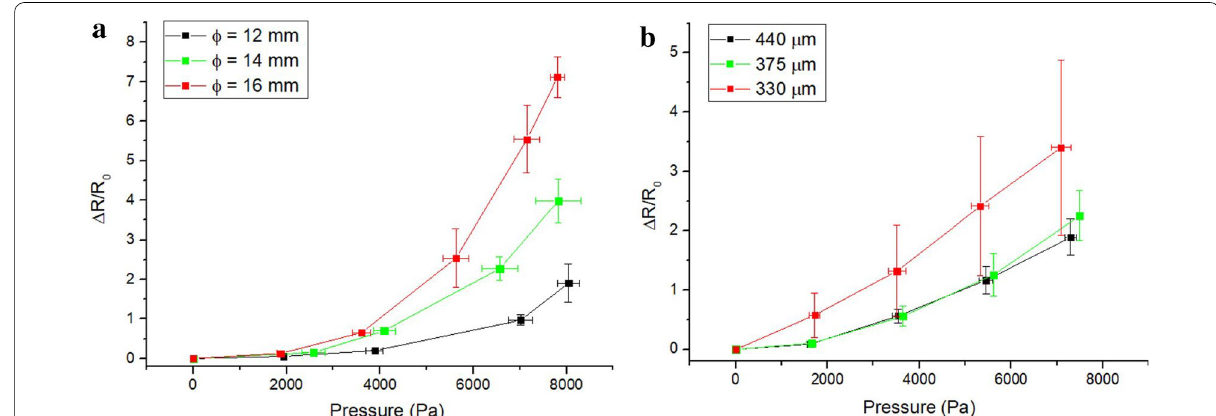
Fig. 4 Sensitivity as a function of a the inner diameter of the connecting module with a fixed PDMS thickness of 375 μm, and b the thickness of PDMS substrate with a fixed inner diameter of 12 mm. The square dots represent the averages of the measured relative variation in resistance depending on the averaged pressure load. The error bars along x- and y-axes represent the standard deviations of the measured values of pressure and relative resistance variation, respectively